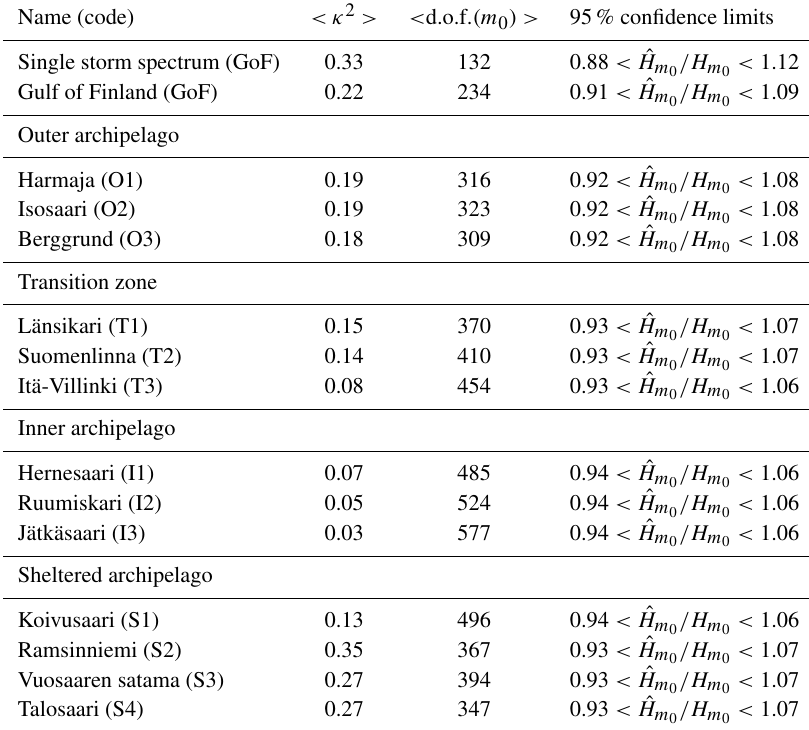
Table 2. Mean values of the spectral narrowness parameter ( κ 2 ) and the number of degrees of freedom for the variance of the wave field. The mean values are calculated only from the data set P80. In the confidence limits, ˆ H m wave height of H m 0